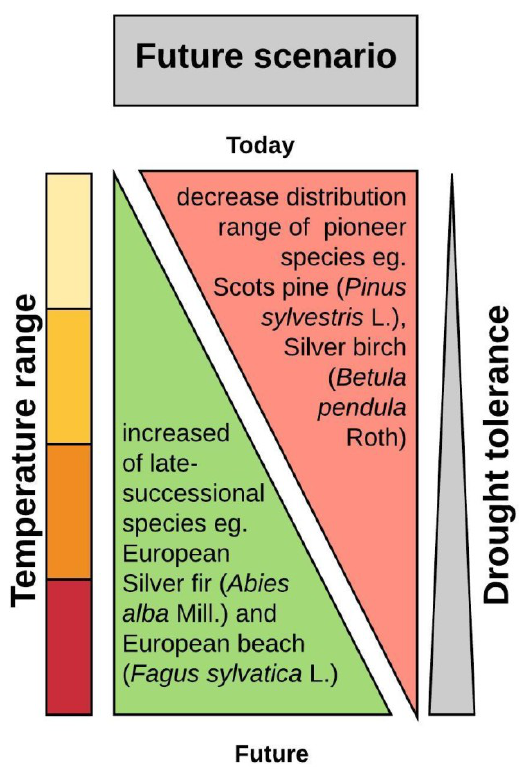
Figure 2. Diagram illustrating future scenario of tree species redistribution according to differences in the temperature range and drought tolerance of species grouped as pioneer and late‐successional.